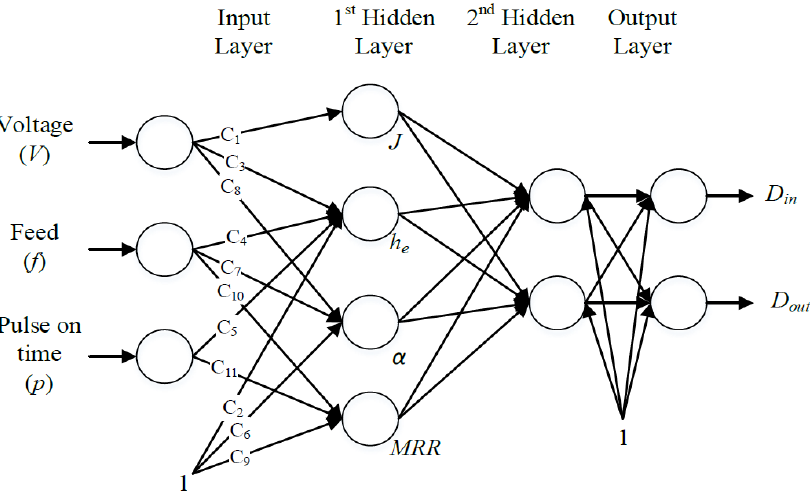
Figure 4. NN structure with embedded partial physical-based knowledge used for the case study of ECM.